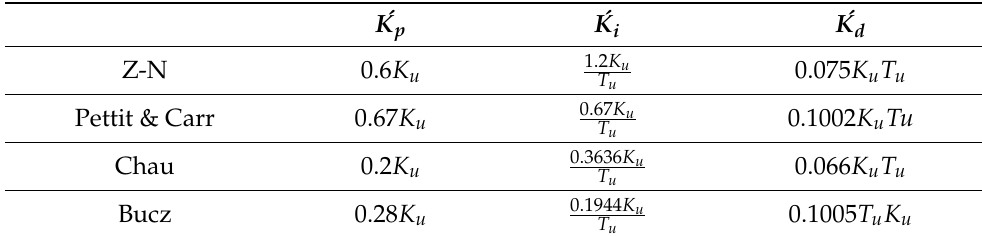
Table 2. Conventional observation methods for tuning